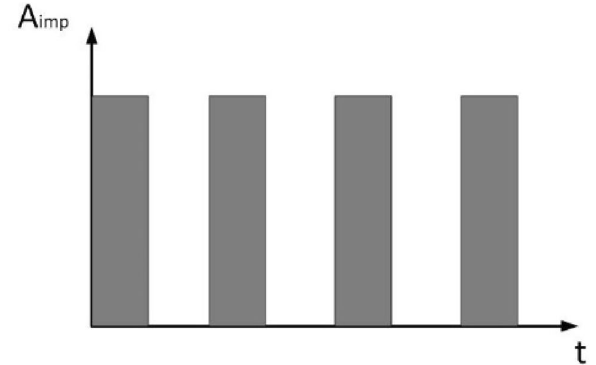
Figure 4. Roller impact force.